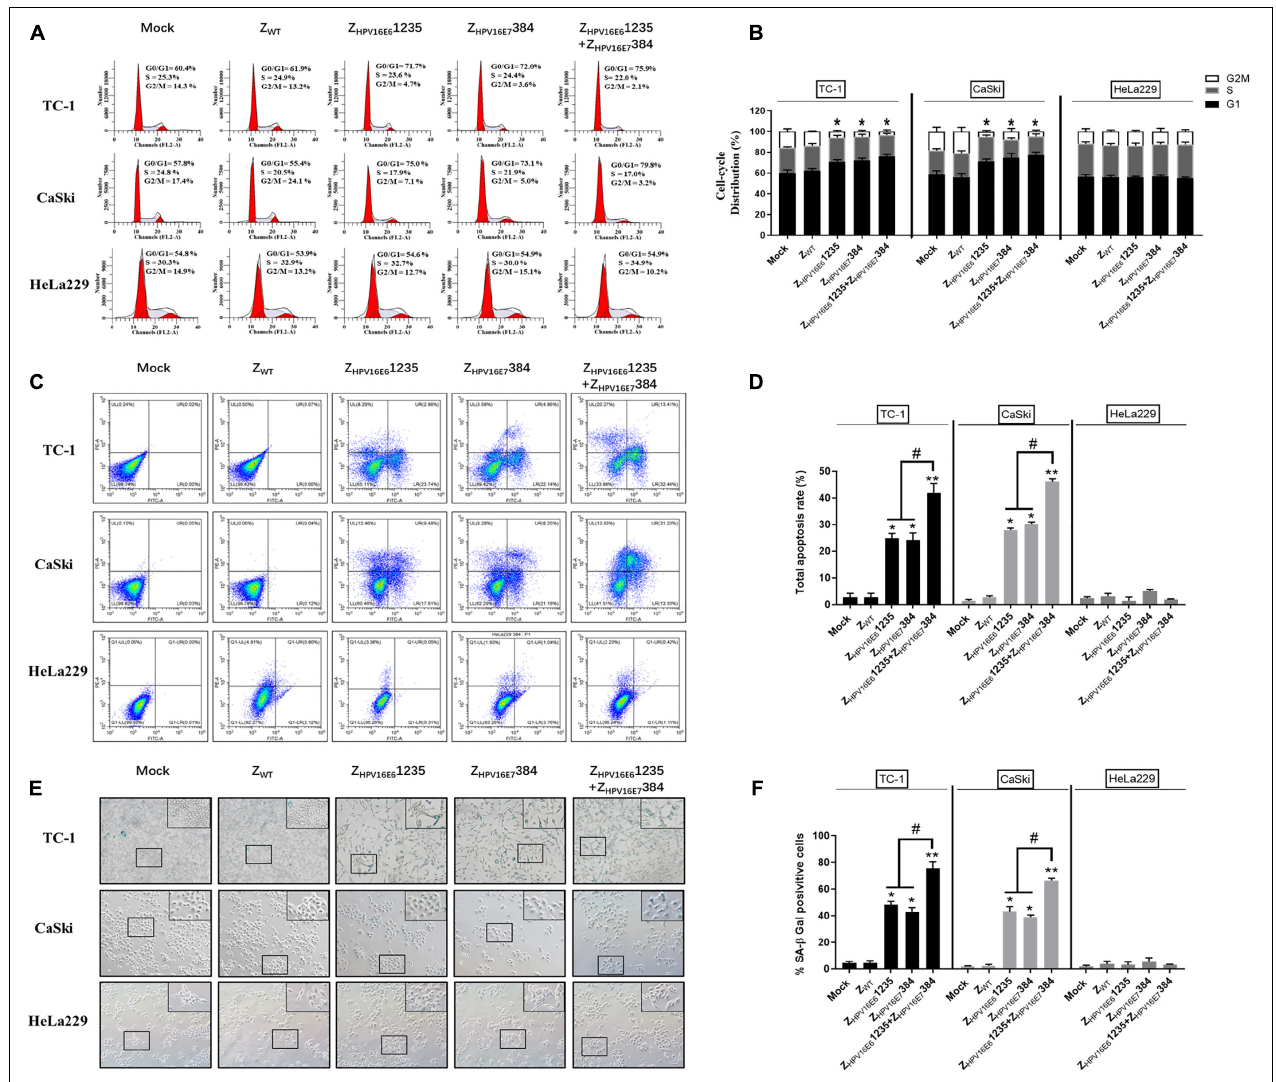
FIGURE 6 | Effect of Z HPV16E6 1235 in combination with Z HPV16E7 384 on the cell cycle, apoptosis, and cellular senescence. TC-1 and CaSki cells were treated with 10 µ M of test affibody molecules for 24 h and analyzed by flow cytometry assay for the cell cycle (A,B) and apoptosis (C,D) with PI and Annexin V/PI. Data are presented as the mean ± SD in three independent experiments. (E,F) SA- β -gal staining of TC-1 and CaSki cells treated with 10 µ M test affibody molecules for 24 h. Representative images taken using a bright-field inverted microscope (100 × magnification) are shown. In all panels, TC-1 and CaSki (HPV16-positive) cells treated with Z WT and HeLa229 (HPV18-positive) treated with selected affibodies were used as negative controls. Significance: * P < 0.05, ** P < 0.01 vs. the control group. # P < 0.05 vs. the Z HPV16E6 1235 or Z HPV16E7 384 alone treatment